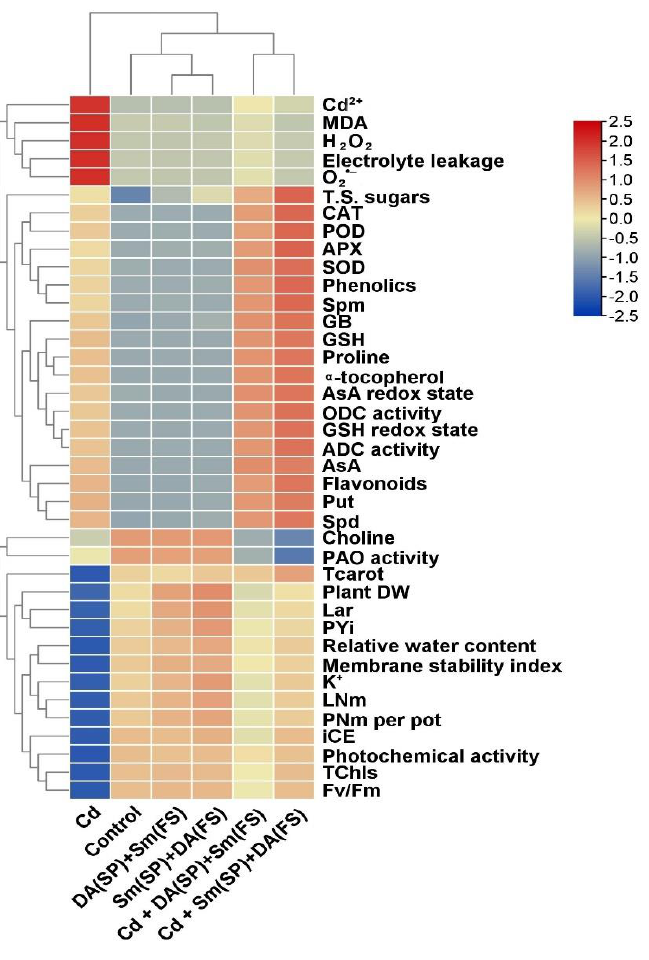
Figure 10. The heatmap graph shows analysis of hierarchical clustering between the examined pa- rameters and treatments. The colors represent variations in the resulting data. TChls = Total chloro- phyll, TCarot = Total Carotenoids, iCE = instantaneous carboxylation efficiency, Fv/Fm = chlorophyll “a” fluorescence, LNm = leaf number, LAr = leaf area, DW = dry weight, PNm = pod number, PYi = pod yield, AsA = Ascorbate, GSH = Glutathione, O 2 •− = Superoxide, H 2 O 2 = Hydrogen peroxide, MDA = Malondialdehyde, EL = Electrolyte leakage, RWC = Relative water content, SOD = Superox- ide dismutase, CAT = Catalase, APX = Ascorbate peroxidase, POD = Peroxidase, Put = putrescine, Spd = Spermidine, Spm = Spermine, ADC = Arginine decarboxylase, ODC = Ornithine decarbox- ylase, and PAO = Polyamine oxidase.